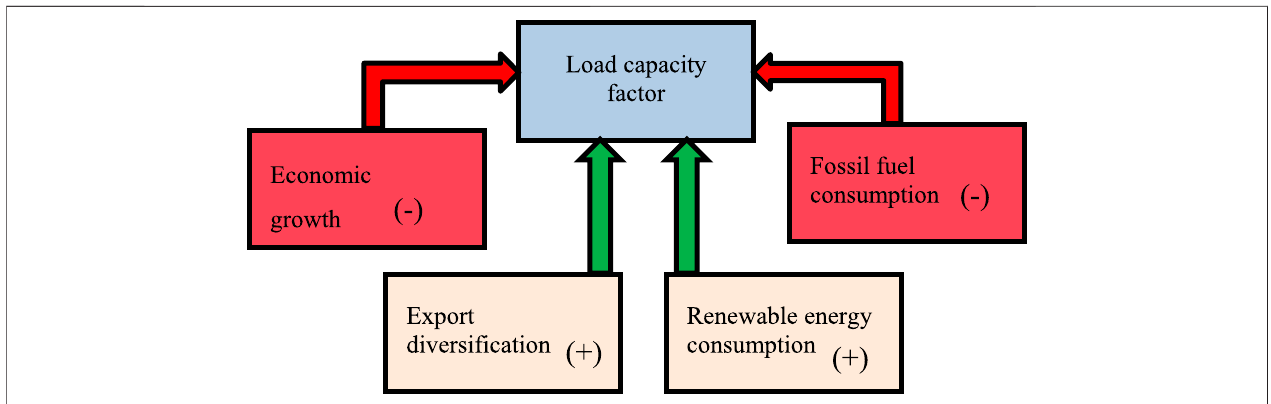
FIGURE 2 | Quantile causality